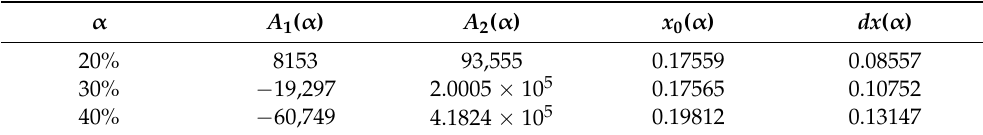
Figure 3. Experimental measurements of the viscosity of the MRGs from top to bottom are 40%, 30%, and 20%. The magnetic field varies from 0 T to 0.8 T, and the shear rate is 0.01 s − 1 . Table 1. Fitting parameters of the viscosity curves.